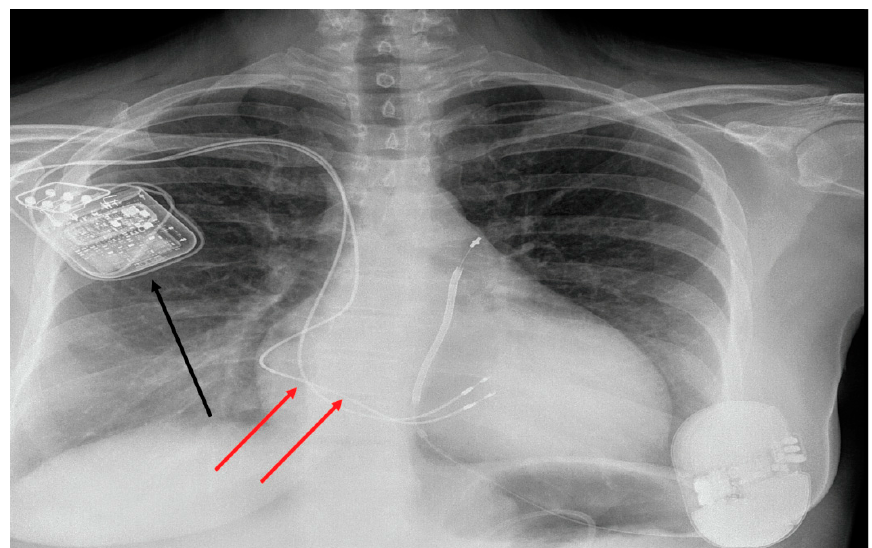
Figure 1. An example of the Optimizer Smart ® implant in a female patient with a subcutaneous ICD. Note the presence of the impulse pocket generator (black arrow) and of two electrodes for the delivery of CCM therapy (red arrows).